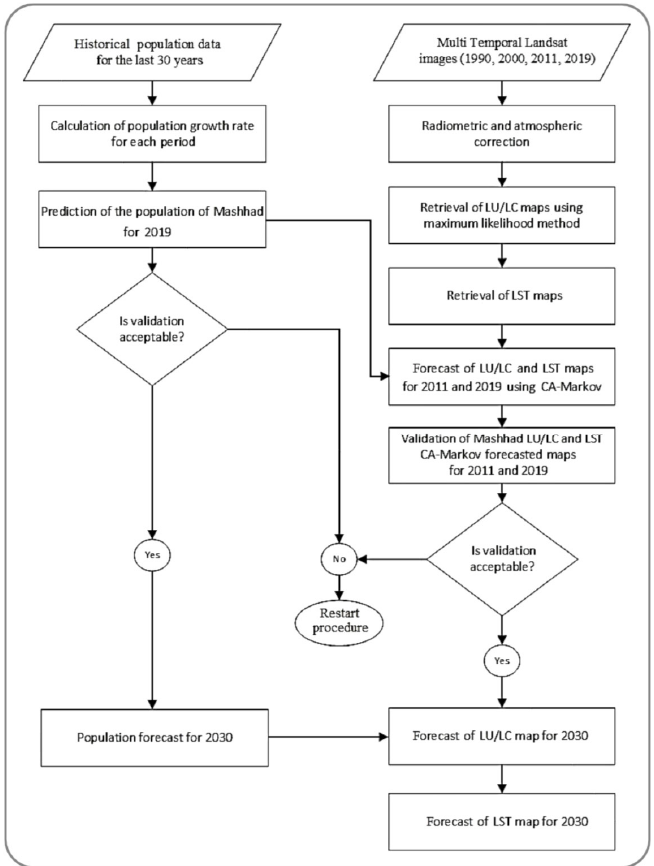
Figure 2. Flowchart of the procedure used to predict Mashhad LU/LC and LST maps for 2030 and the population of Mashhad in 2030.